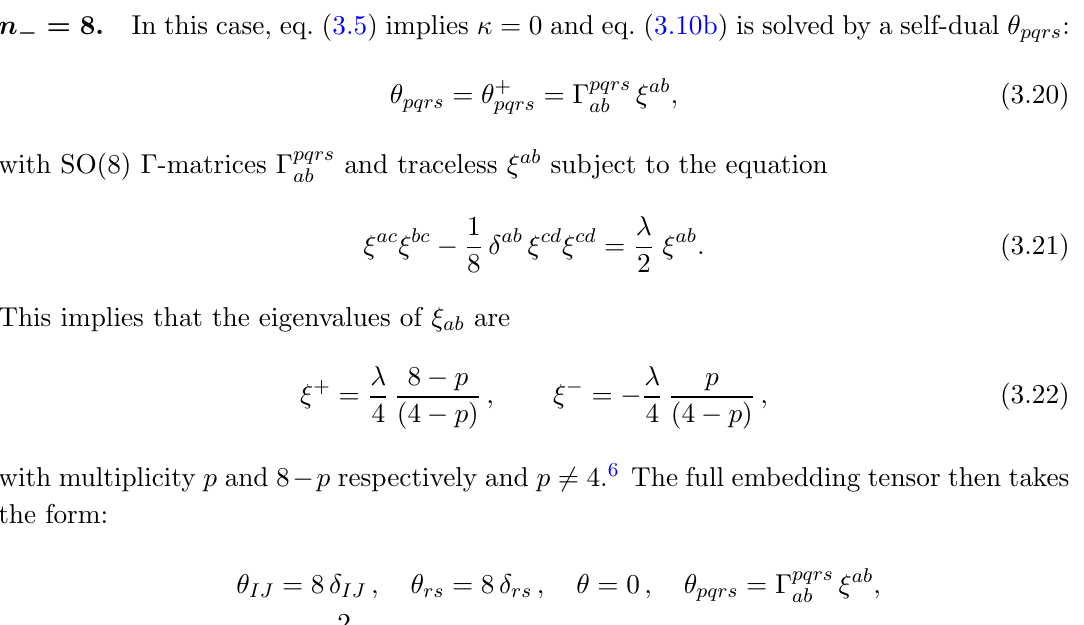
2 ; R ), given in eq. (5.3) j ) in (a) reduces to (cid:0)